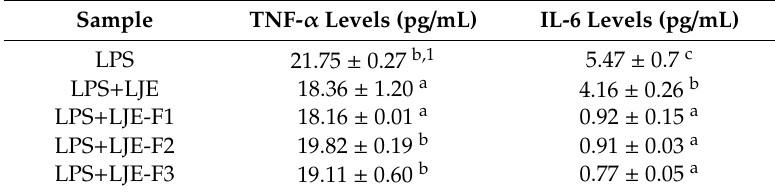
Table 2. E ff ect of LJE and LJE-Fs on TNF- α and IL-6 production in the LPS-stimulated Caco-2